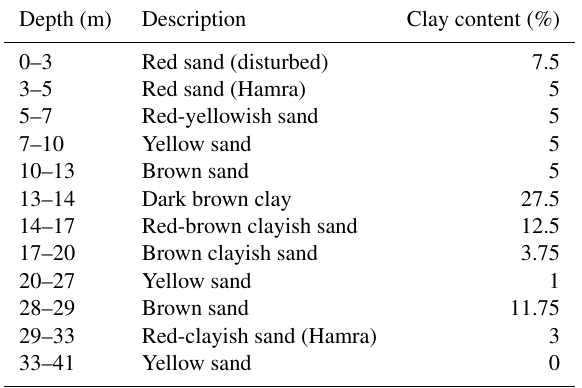
Figure 1. Initial concentration profiles of chloride and perchlorate in the vadose zone pore water under the former waste lagoon, along with the lithological profile. Table 1. Sedimentological composition of the vadose zone at the pilot site.